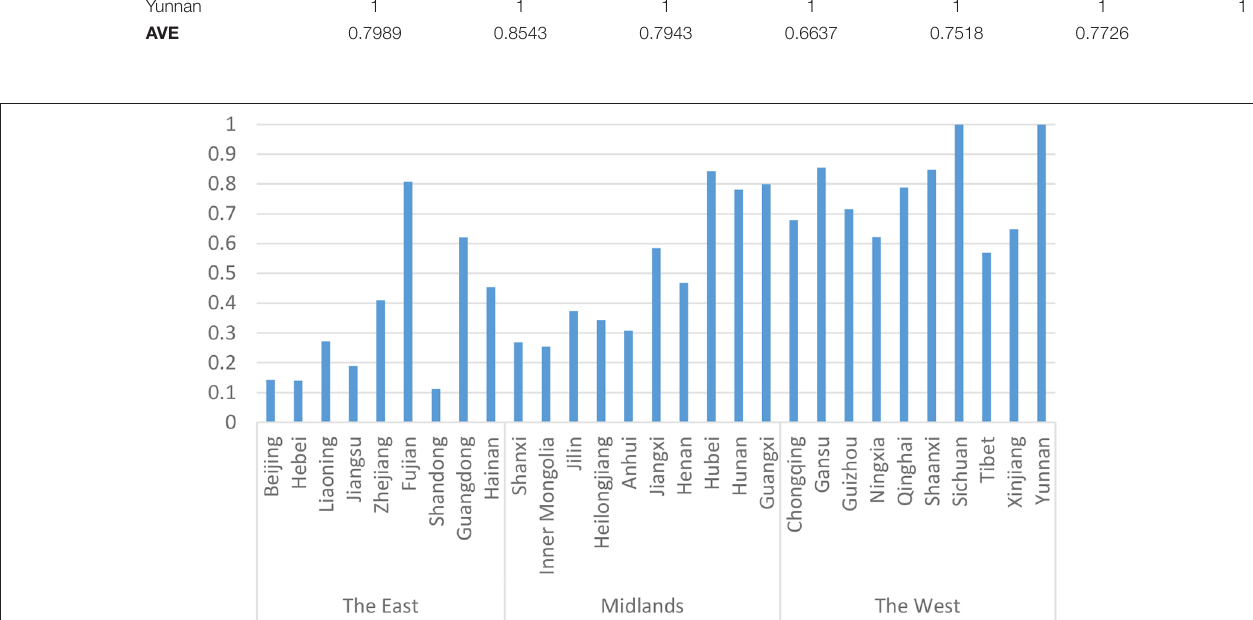
FIGURE 2 | Total efficiency scores among provinces by region from 2013 to